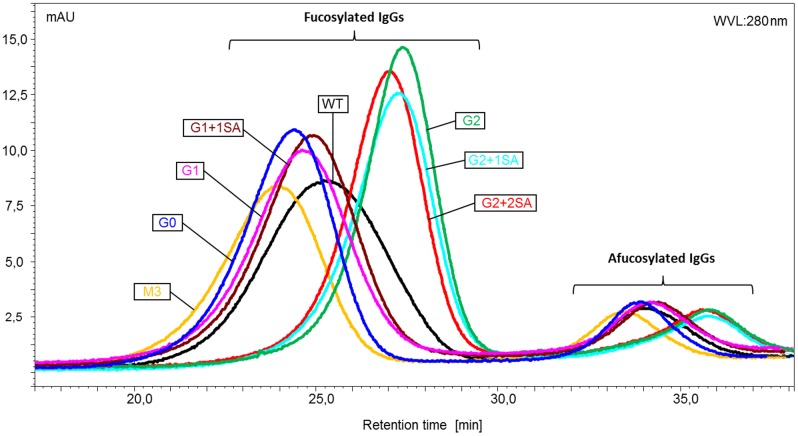
Retention profiles of the IgG1 glycovariants obtained by analytical FcγRIIIa affinity chromatography.The chromatograms, obtained by monitoring signal at 280 nm, show two peaks corresponding to fucosylated and afucosylated antibody fractions (deglycosylated IgG is not shown).